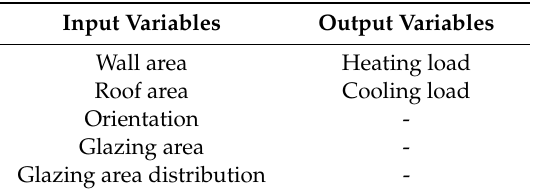
Table 5. Input and output variables considered for the modelling of the energy e ffi ciency problem with octahedric regression.